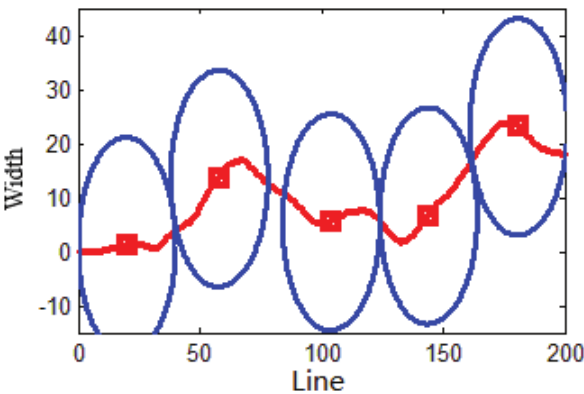
Figure 16: Case 3: The optimal complicated tunnels by ECO algorithm (R = 20)